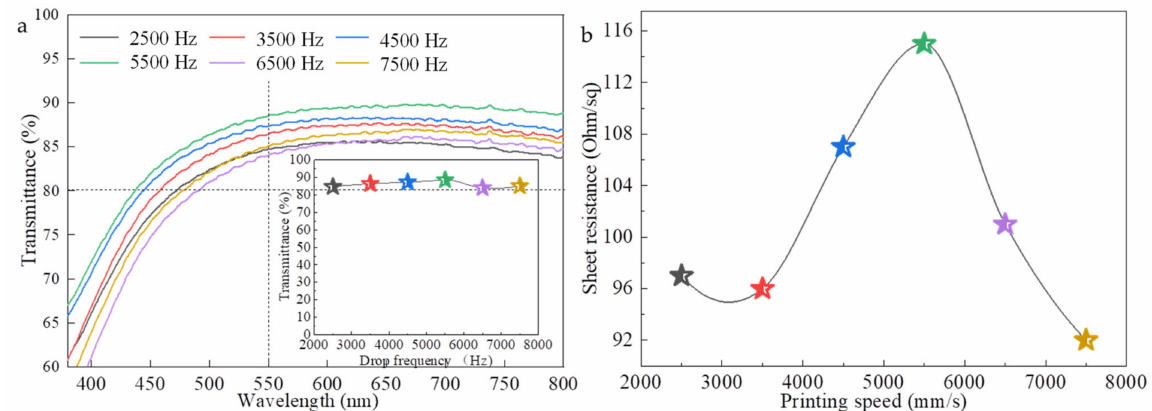
Figure 8. Transmittance ( a ) and sheet resistance ( b ) of the AgNWs films with different drop frequencies. The insert is transmittance at 550